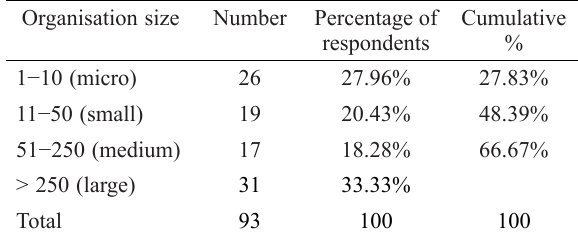
Table 4. Organisation size from sample